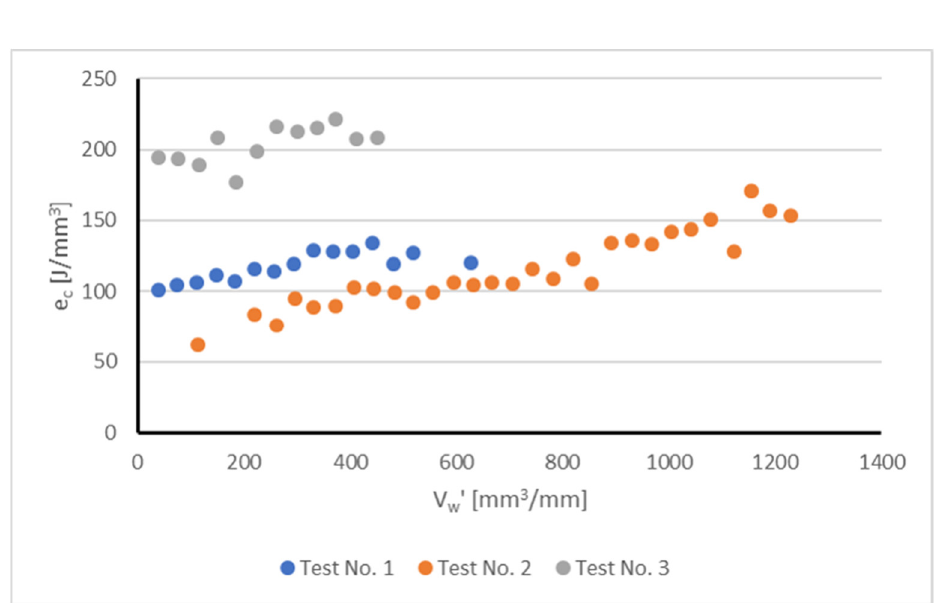
Figure 3. Experimentally measured specific grinding energy e c (J/mm 3 ) as a function of the specific volume of part material removed V’ w (mm 3 /mm) during the tests.